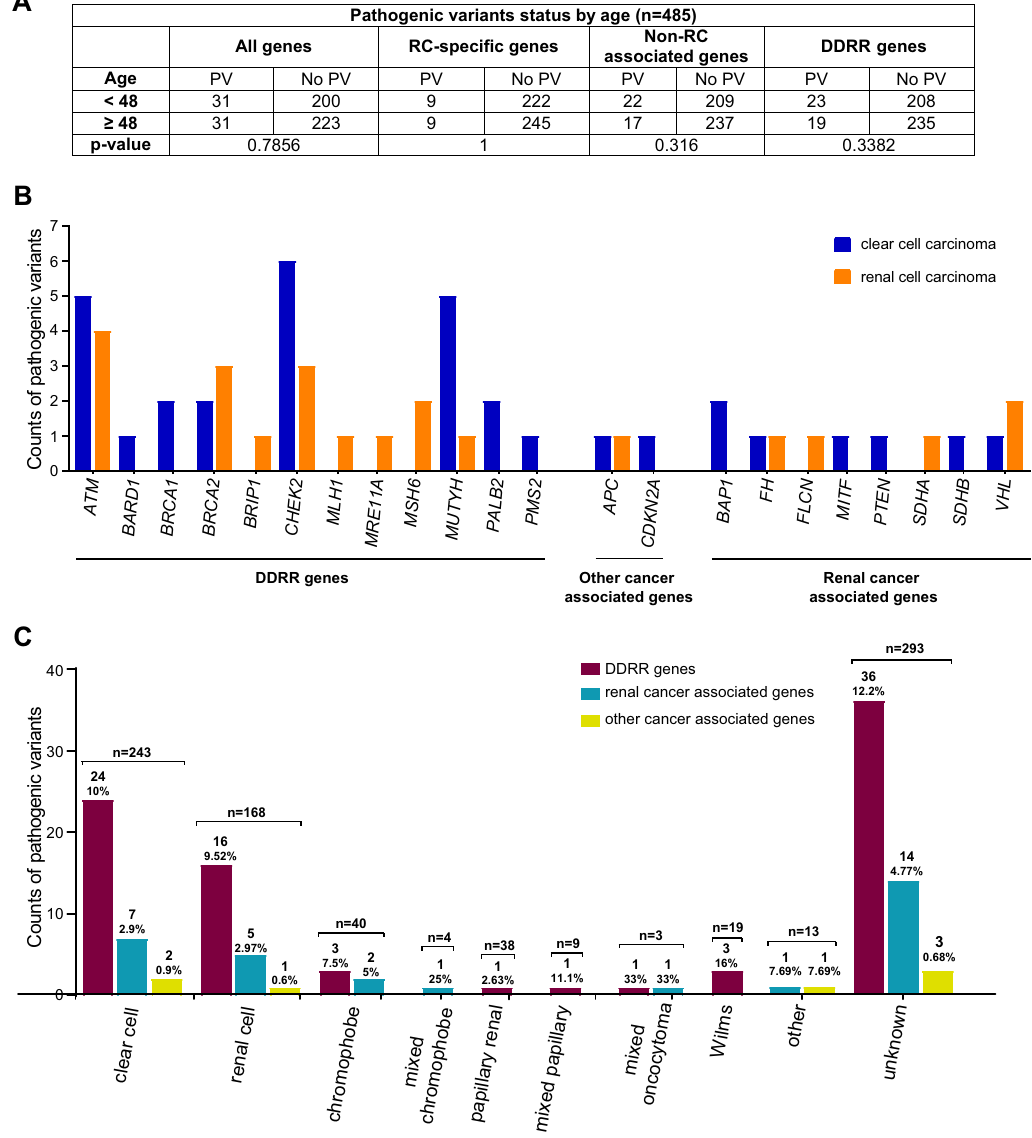
Figure 3. Identified PVs compared to age of RC diagnosis, and histology of RC. ( A ) Statistical comparison of PVs in all genes, RC-specific genes, non-RC and DDRR genes in younger individuals (< 48) versus older individuals (≥ 48). N = 485, these cases were tested for all 49 genes; all cases with Wilms tumor were removed. The results were non-significant (p > 0.05) using two-sided Fisher’s exact tests. ( B ) Counts of PVs by RC histology: clear cell (blue bar) and renal cell (orange bar) carcinoma in the study cohort. The’ renal cell’ subtype, is likely clear cell, but this cannot be confirmed. ( C ) Counts of PVs by all RC histology observed in the study cohort. DDRR genes (maroon bars), other-cancer associated genes (yellow bars), RC-specific genes (blue bars). The total number of individuals with a PV and percent PVs per gene category is shown above the bar. ( B , C ) Includes counts from both homozygous and heterozygous carriers of MUTYH, and carriers of a FH variant that is currently considered to be pathogenic only in the compound heterozygous or homozygous